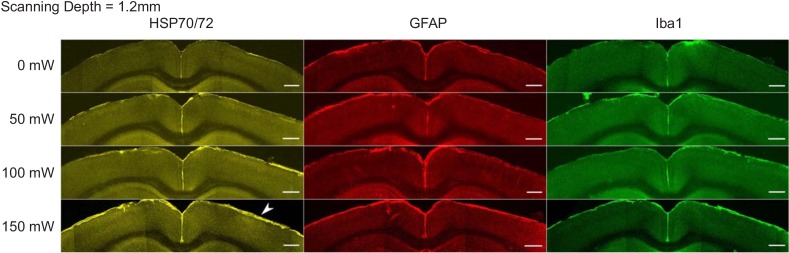
Immunostaining reveals brain tissue damage by 1320 nm 3PM with 150 mW imaging power after the objective lens at 1.2 mm imaging depth.The scanning was performed with 230 μm FOV for 20 min at various average powers in the mouse brain. The window and scanning area are on the right side of each brain slice, and the location of heating is indicated with white arrowheads. Scale bar, 500 μm.